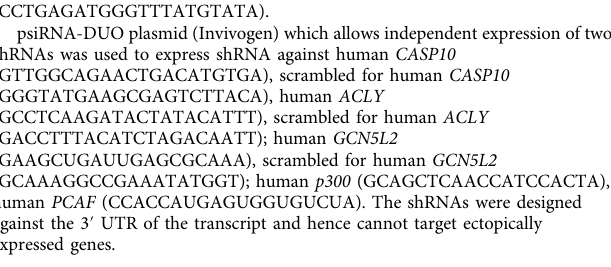
Fig. 6 Caspase-10 represses ACLY promoted malignant phenotype a , b A549 control (control), caspase-10 knockdown (CASP10kd), caspase-10/ACLY double knockdown (CASP10kd/ACLYkd), caspase-10/GCN5 double knockdown (CASP10kd/GCN5kd), and caspase-10/ACLY/GCN5 triple